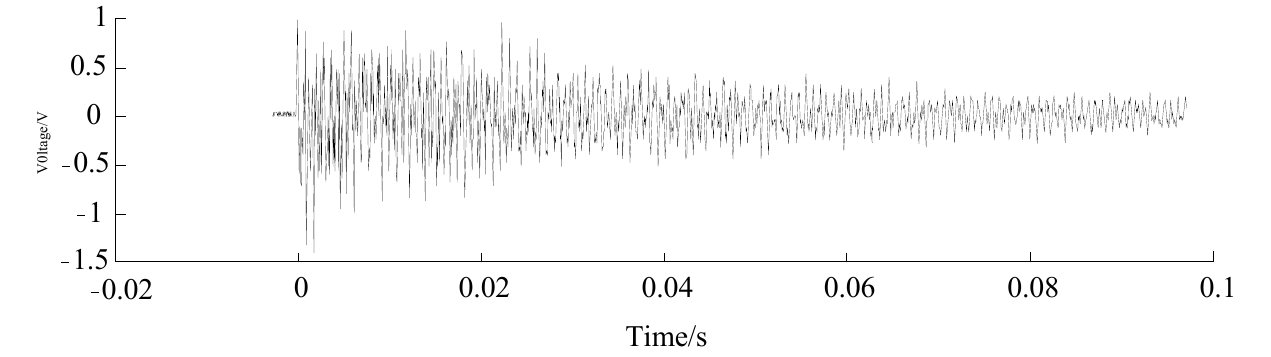
Figure 3. Corn kernel impacting signal diagram.